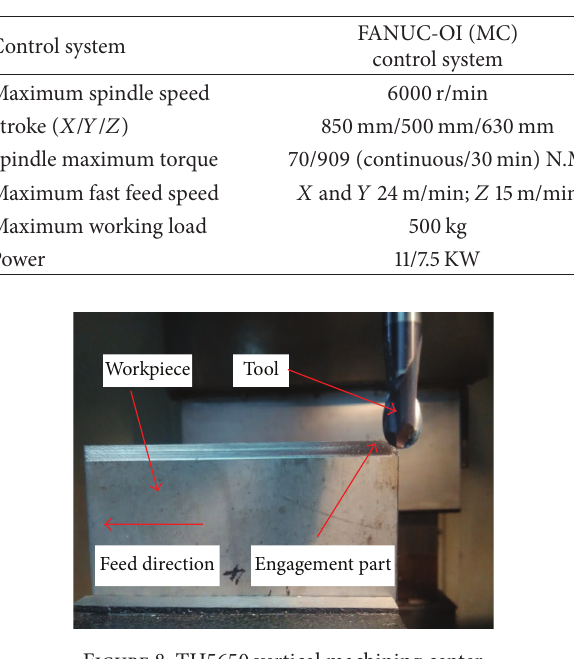
Table 1: Main parameters of machining center.